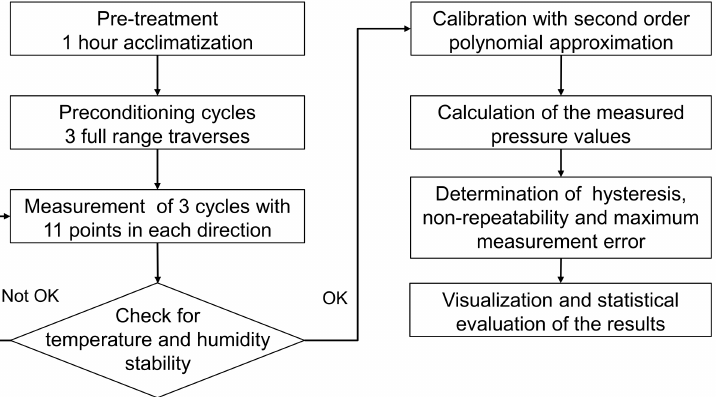
Figure 11. Flowchart of the measurement procedure for the characteristic curves.